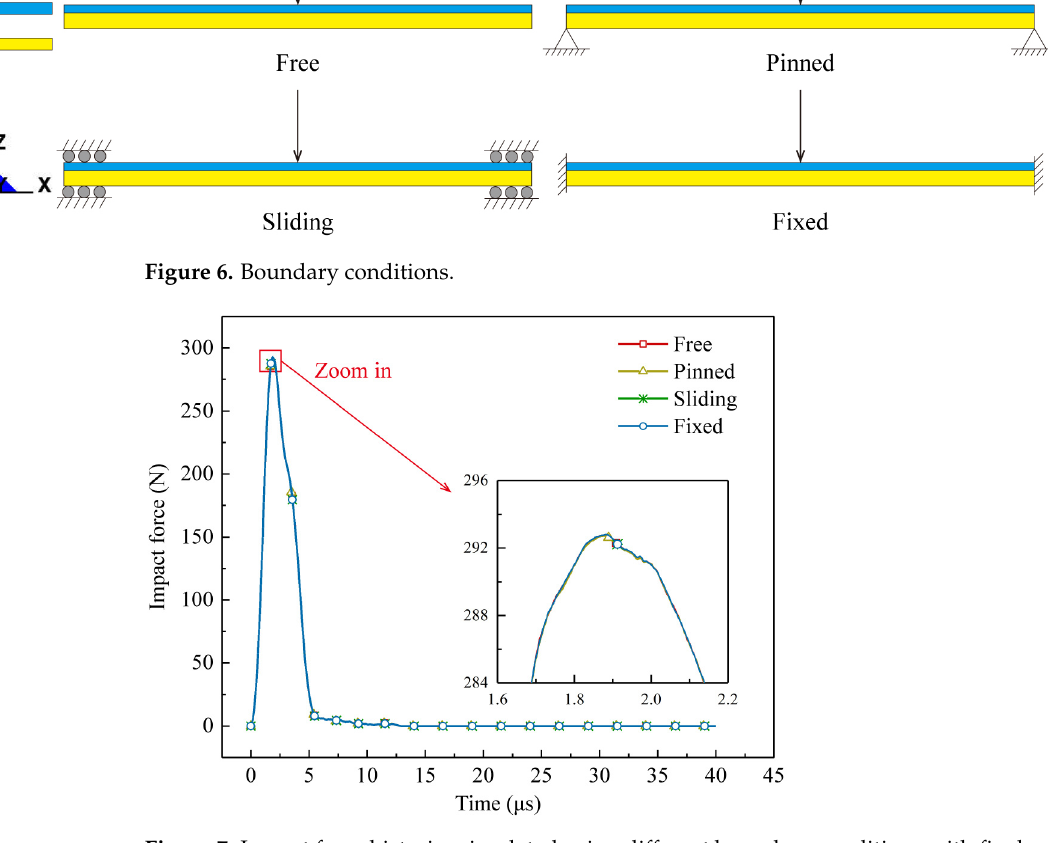
Figure 7. Impact force histories simulated using different boundary conditions with final mesh. Table 8. Predicted delamination area sizes using different boundary conditions with final mesh.